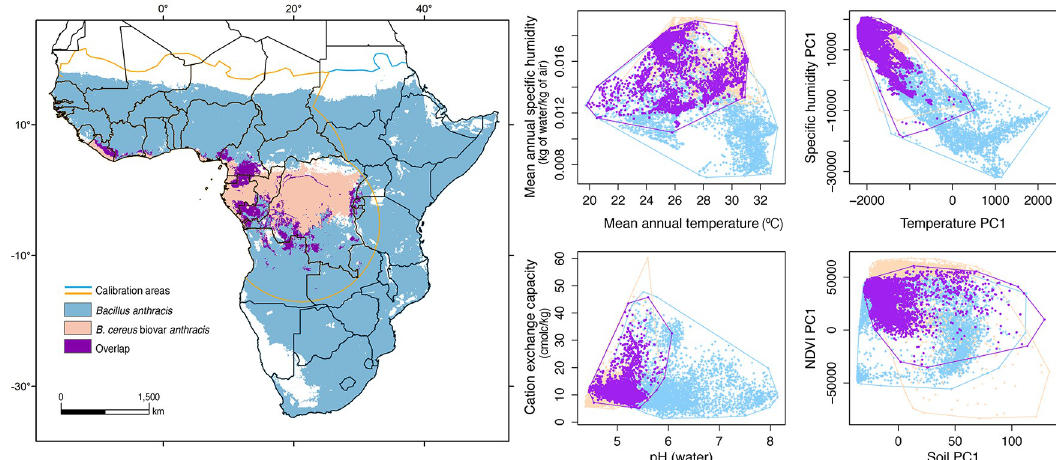
Fig 3. Overlapping regions for both pathogens. Bacillus anthracis (light blue) and Bcbva (light orange) suitability as relates to the Bcbva calibration area (orange line) using a minimum training presence threshold among the best performing models. Environments in these areas are characterized via a sample of 5000 points (right panels, same color scheme) considering four individual environmental variables (mean annual temperature, mean annual specific humidity, soil pH, and soil cation exchange capacity) and the first principal component (PC1) of the four environmental dimensions explored in this manuscript (temperature, specific humidity, vegetation greenness or NDVI, and soils). Maps were developed using shapefiles summarizing political borders of Africa from the public domain repository of Natural Earth (http://www.naturalearthdata.com/) and built with QGIS 2.18 ‘Las Palmas’.